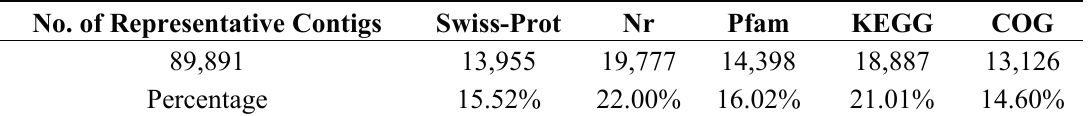
Table 2. Result of functional annotation of the assembled representative contigs to the